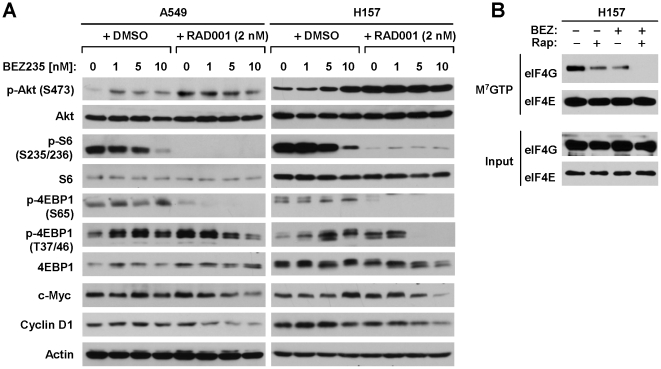
Effects of BEZ235 and RAD001 combination on the mTOR signaling (A), on the expression of mTOR-regulated proteins (A) and on the assembly of eIF4F complex (B).
A, The indicated cell lines were plated in 10 cm-diameter cell culture dishes and treated next day with the given concentrations of BEZ-235 in the absence and presence of RAD001 for 24 h. The cells were then harvested for preparation of whole-cell protein lysates and subsequent Western blot analysis to detect the indicated proteins. B, The indicated cell lines were treated with 2 nM RAD001, 10 nM BEZ235 or their combination. After 24 h, the cells were harvested for preparation of whole-cell protein lysates and subsequent m7GTP pull-down assay followed with Western blot analysis to detect the given proteins.